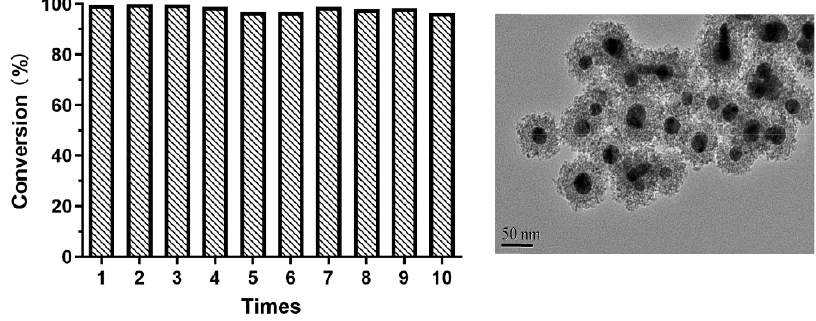
Figure 11. Conversion and TEM image Ag@SiO 2 (prepared by CH 2 O) after 10 cycles of nitrobenzene hydrogenation.